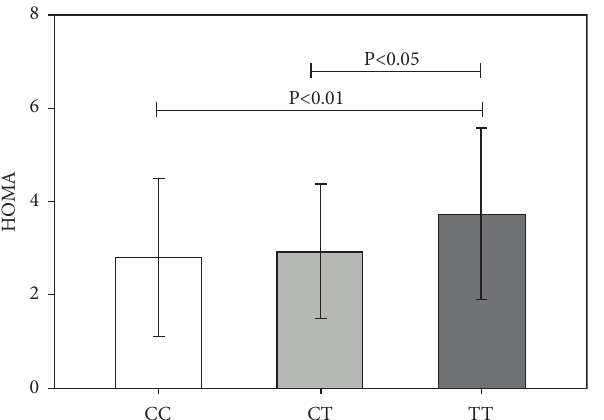
Figure 1: Comparison of the homeostatic model assessment of insulin resistance (HOMA-IR) values of INSR C/T SNP in CC vs. CTvs. TT genotypes. P values calculated by one-way ANOVA and intergroup differences tested by post hoc Tukey HSD test. P=0.52